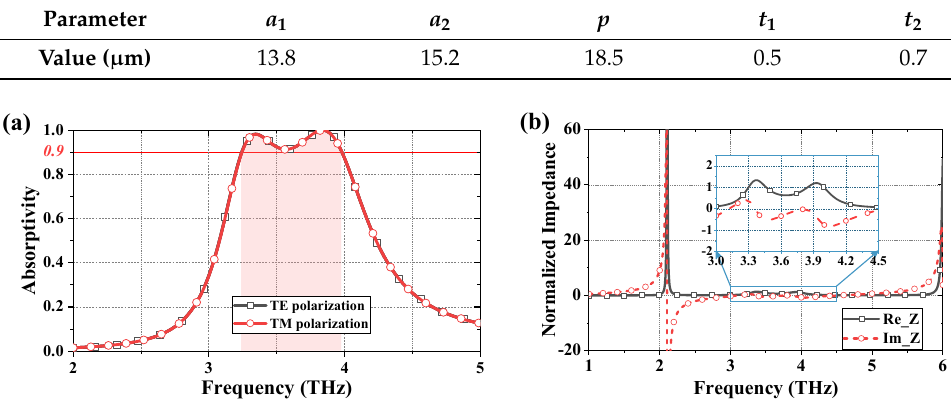
Figure 4. ( a ) The simulated absorption spectra of metasurface absorber under normal incidence with TE and TM polarization. ( b ) Normalized impedance of composite metasurface, and the magnified view within the absorption band (shown in blue frame).